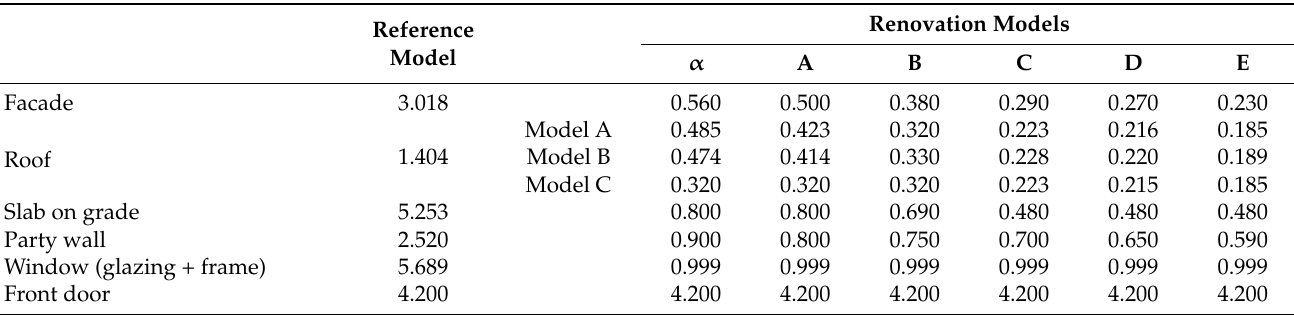
Table 2. Thermal transmittance (W/m 2 K) of the envelope’s elements in the reference model and in the renovation proposed with models A, B and C.